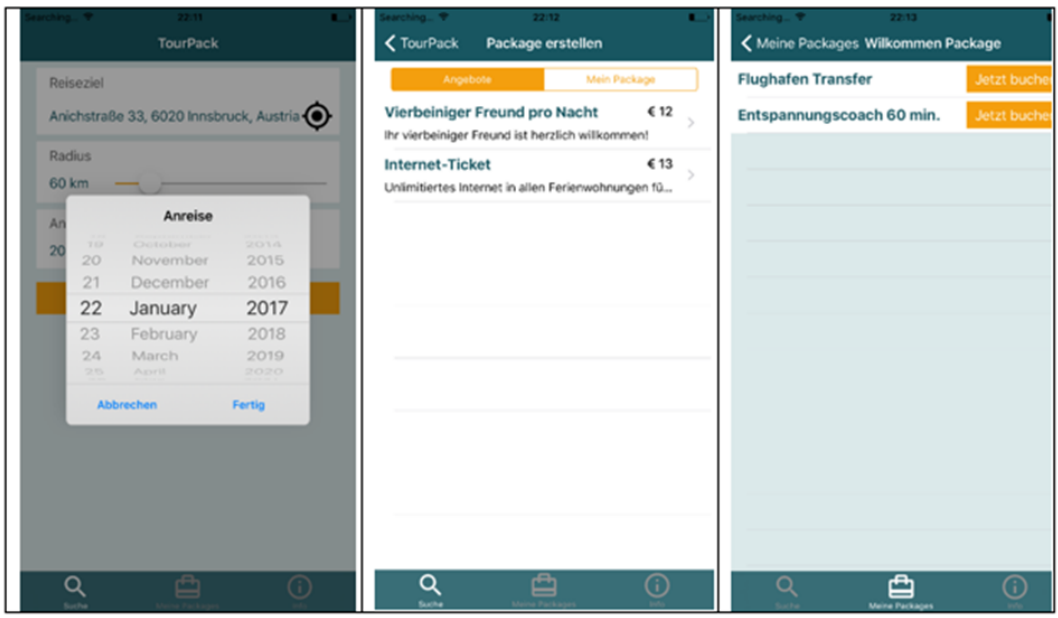
Figure 4. TourPack iOS mobile client